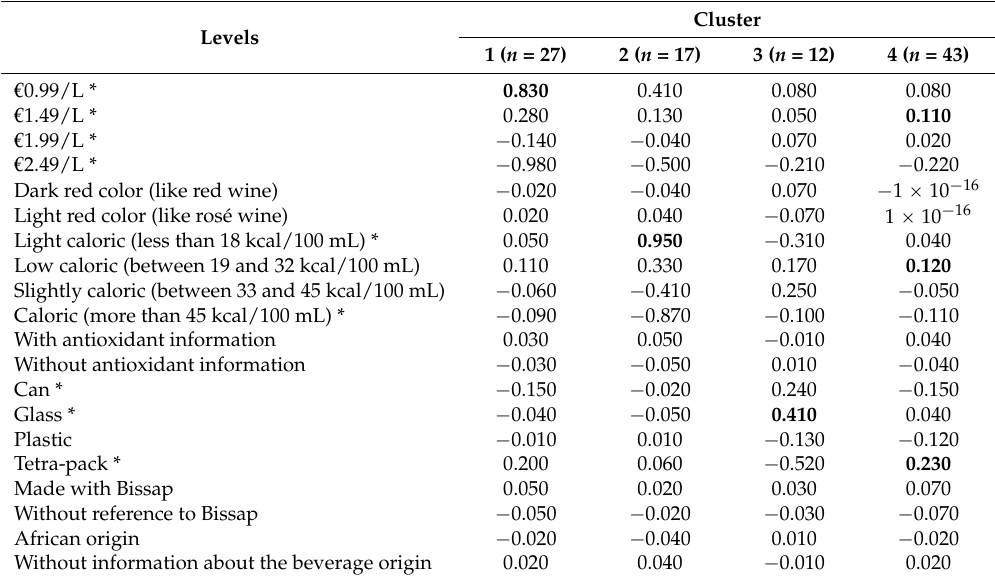
Table 8. Profiling performance of each cluster (utilities of levels).